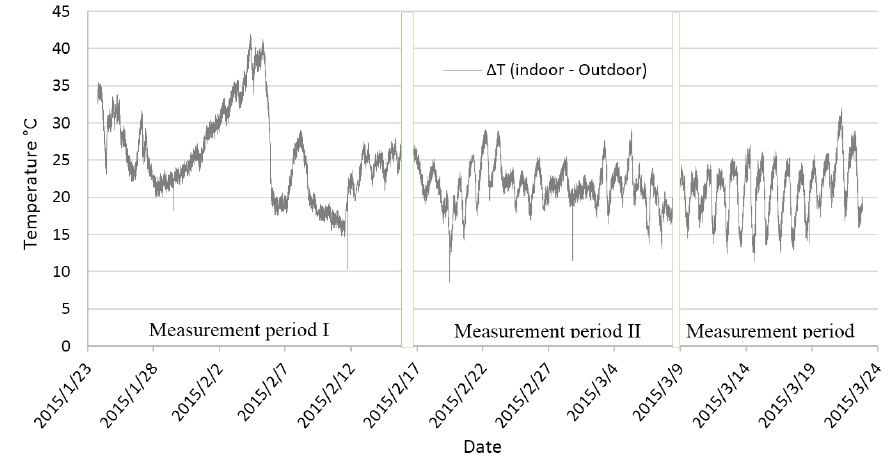
Figure A2. The difference between the indoor and outdoor ambient air temperature with 15 min sampling interval between measurements.